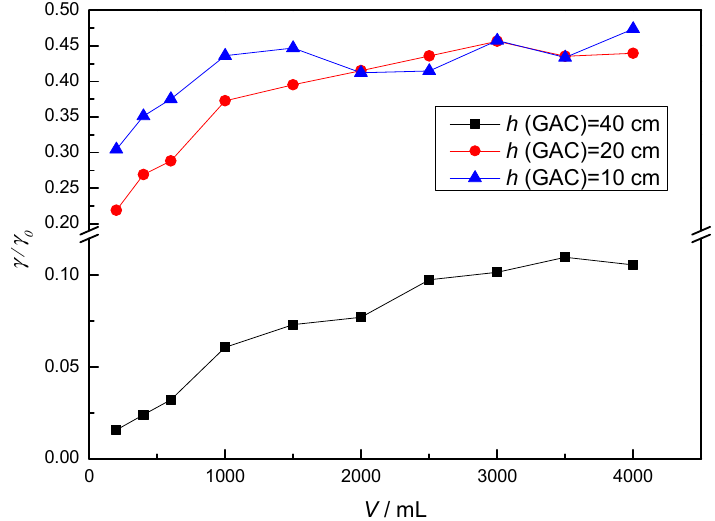
Figure 3. Breakthrough curves at different GAC column heights.